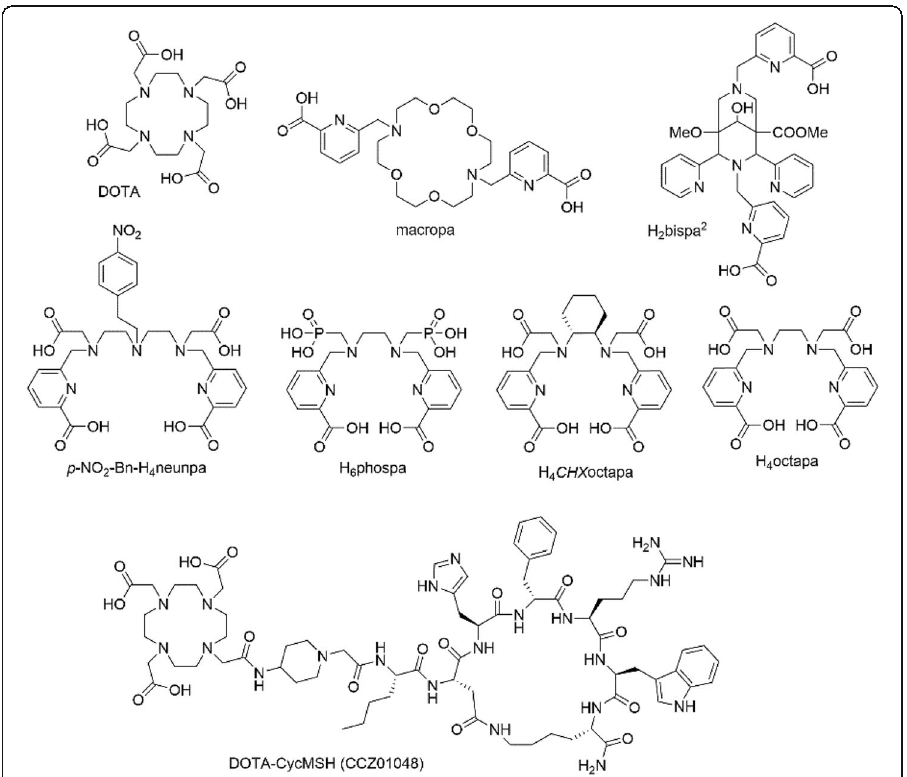
Fig. 1 Ligand structures discussed in this work: macrocyclic commercial standard DOTA, previously reported ligands macropa and H 2 bispa 2 , acyclic picolinic acid “ pa ” ligands p -NO 2 -Bn-H 4 neunpa, H 6